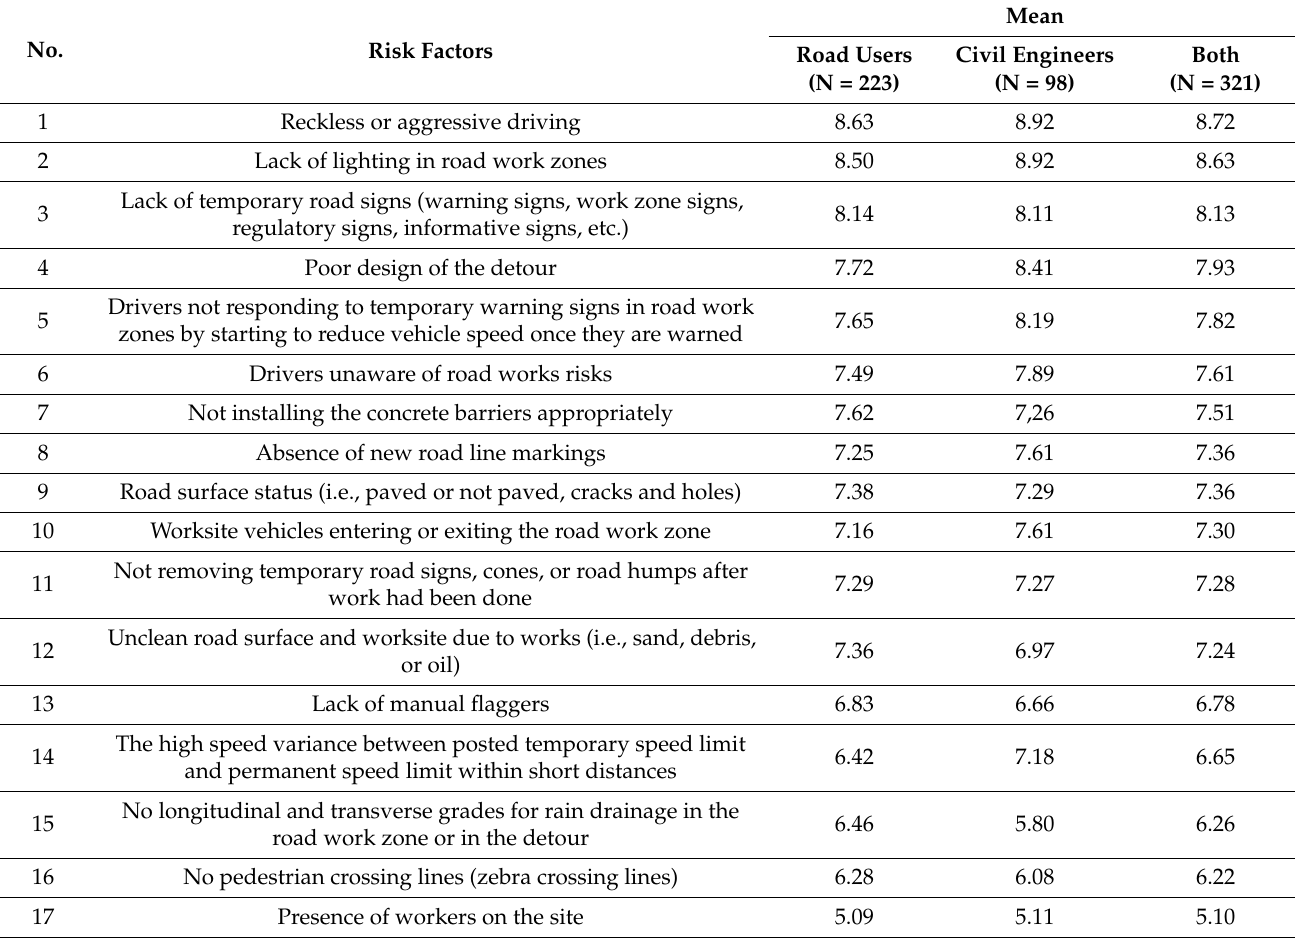
Table 4. The mean of each group and the combined mean of the risk